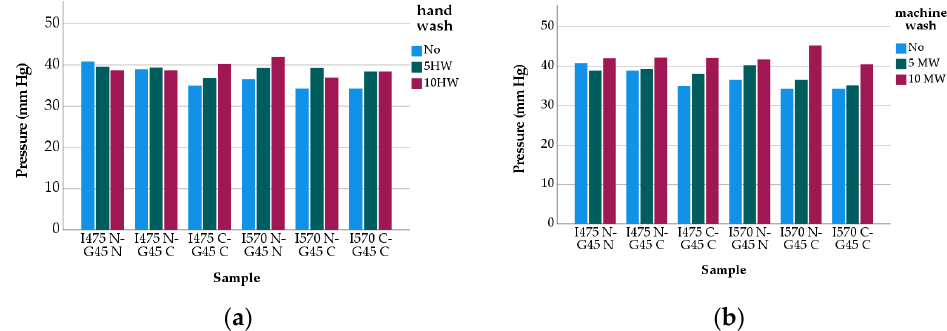
Figure 5. Compression Pressure Change: ( a ) Hand-wash vs. ( b ) Machine-wash.